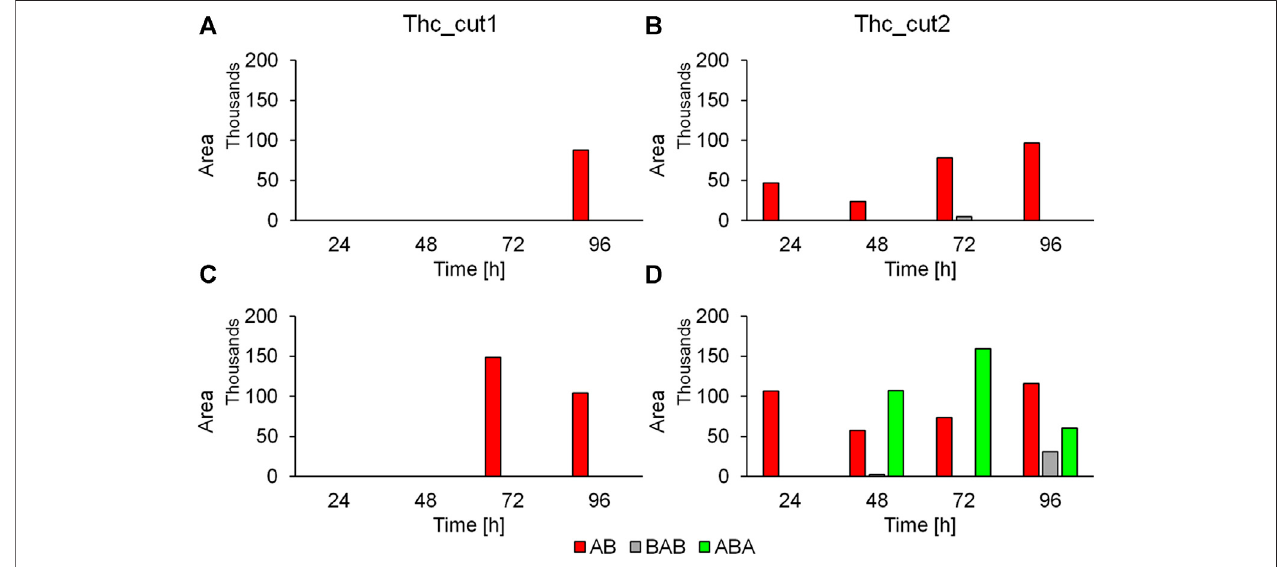
FIGURE5| Released oligomersfrom thePPeTF hydrolysis determined viaLC-TOF/MSanalysis.Timecourse reaction showing thereleased dimers AB,ABA, and BABfortheenzymatichydrolysisperformedat50 ° C(panels A and B )and65 ° C(panels C and D )whenusingThc_cut1(panels A and C )andThc_cut2(panels B and D ). The reactions were performed in 1 M KH 2 PO 4 /K 2 HPO 4 buffer pH 8.0. No released products were detected in the control